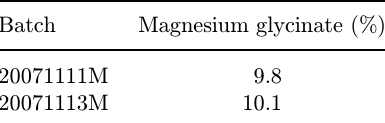
Table 3. The contents of magnesium ion in magnesium glycinate.